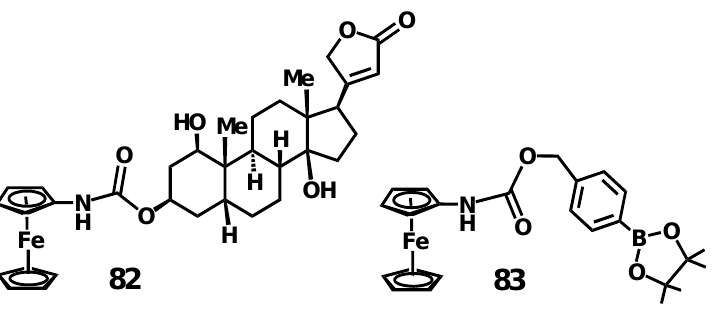
Figure 4. Steroidal and boronic acid ester carbamates derived by reaction of alcohols with ferrocenyl isocyanate.